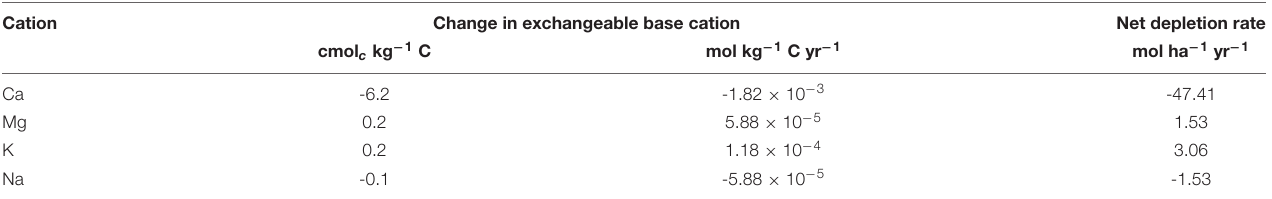
TABLE 3 | Average annual change for each exchangeable base cation from 1984 to 2001 for the Catskills/Poconos region and the average annual rates of net depletion (negative) or accumulation (positive) from soil exchange (data sources: Warby et al., 2009; Johnson, 2013). Cation